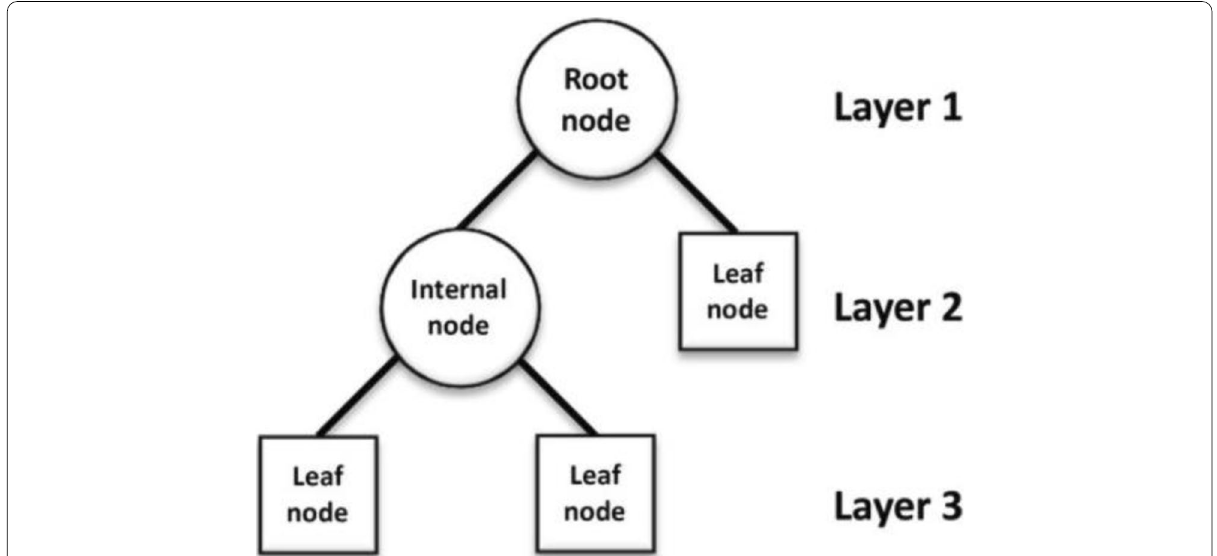
Fig. 2 Basic structure of decision tree showing three different hierarchical layers